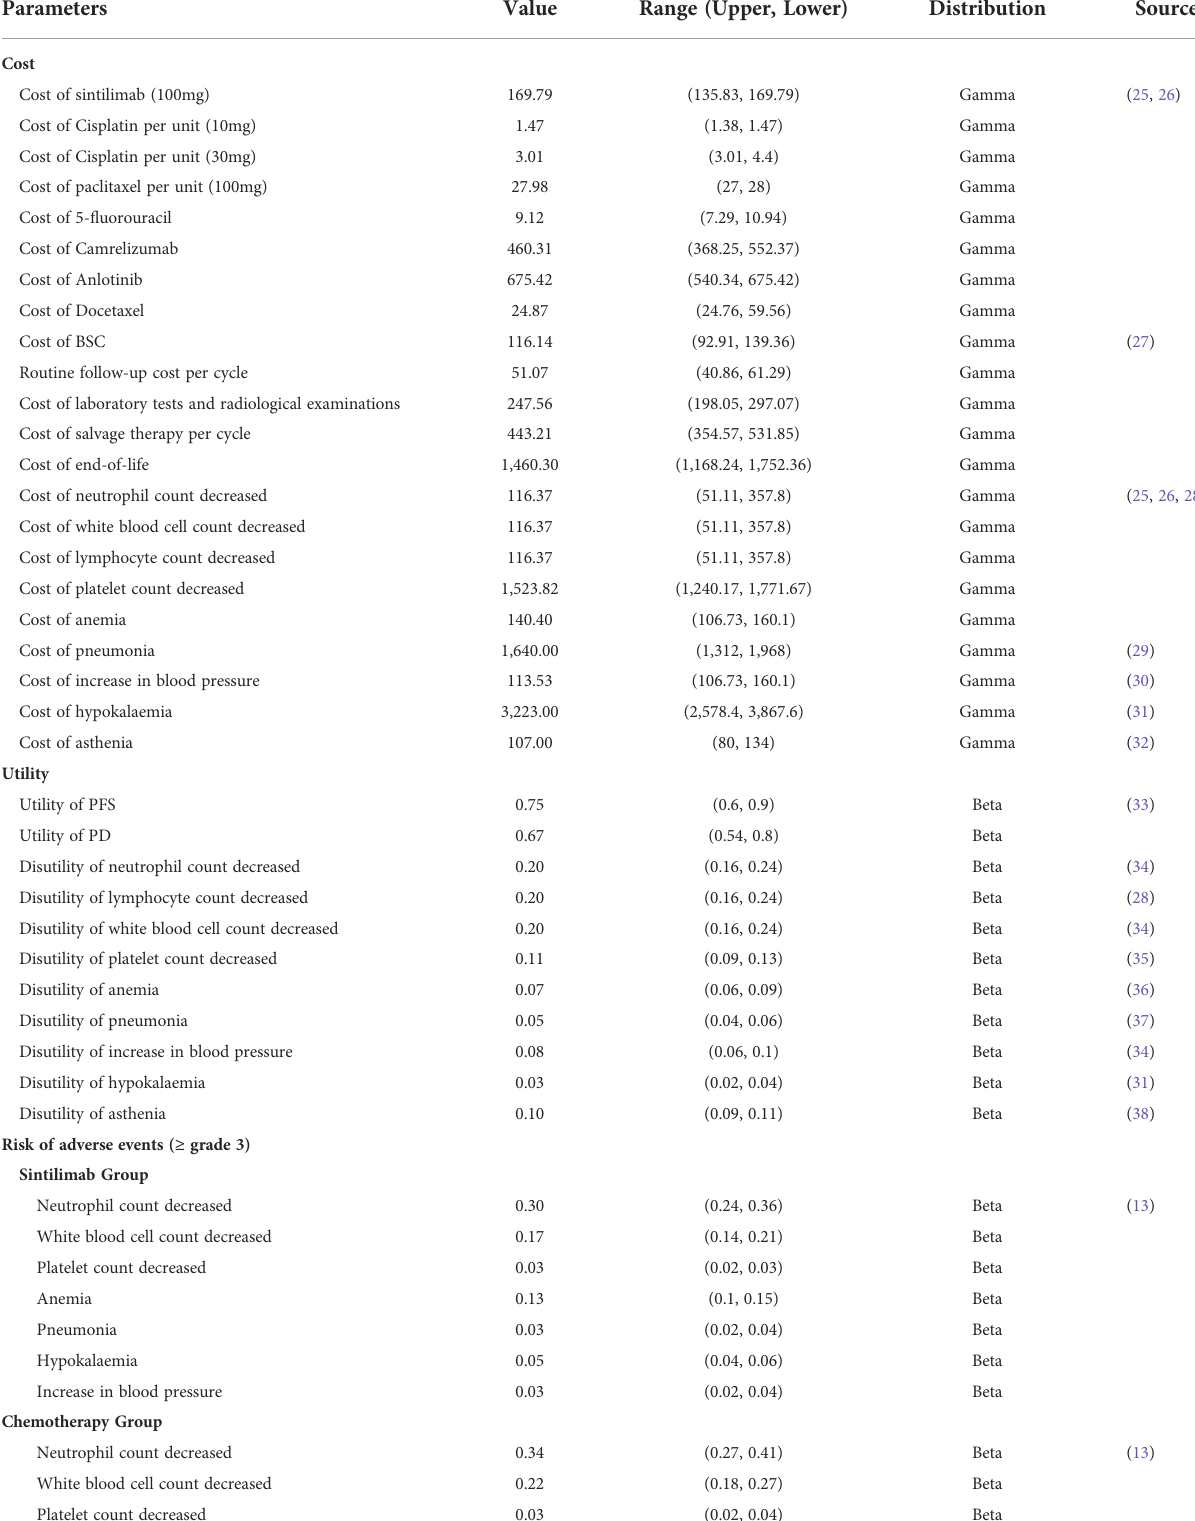
TABLE 1 Key model parameters